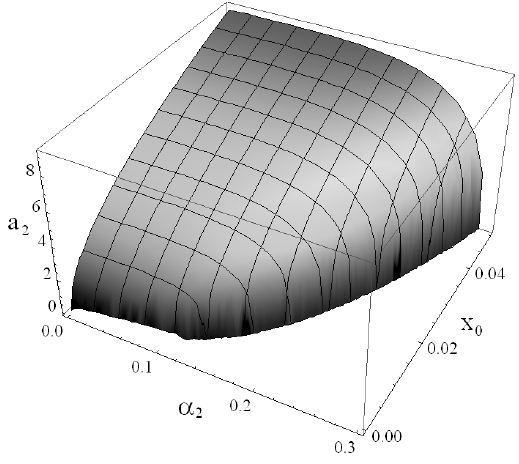
Fig. 11. Controller response versus controller damping and amplitude of excitation; Ω = 3.06309. control, for the full frequency